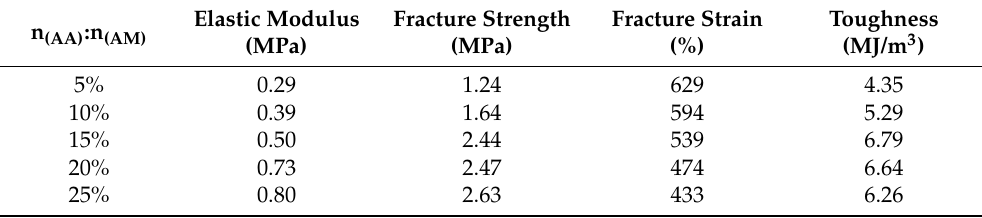
Table 2. The detailed mechanical properties of the DN hydrogels with different molar ratios of AA to